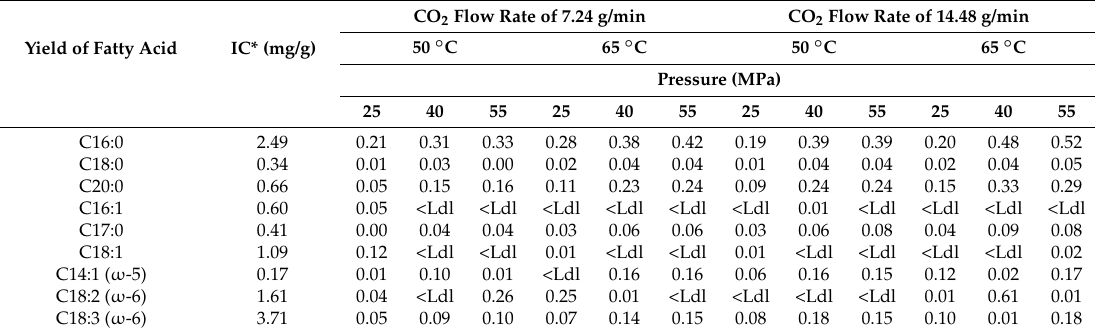
Table 2. Effect of SF-CO 2 operating conditions on fatty acids from S. almeriensis -pretreated biomass.